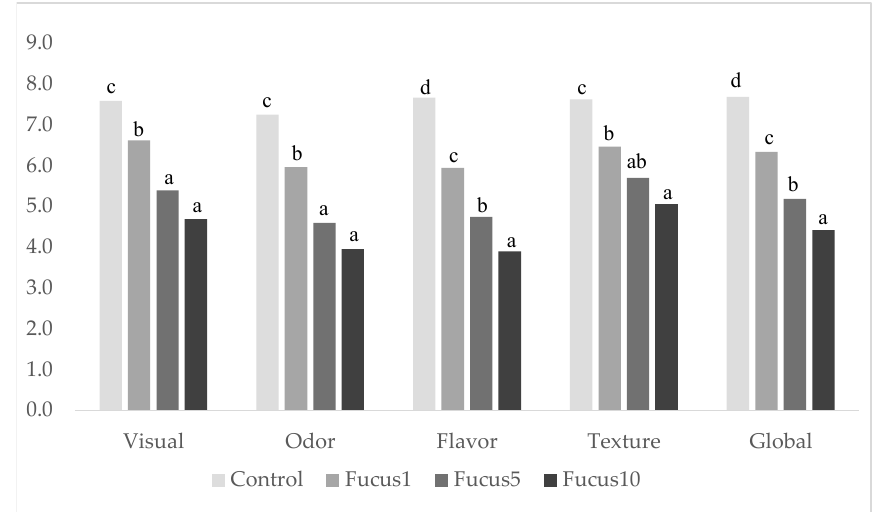
Figure 2. Sensory scores of semolina pasta (CTRL) and pasta enriched with F. vesiculosus (F1, F5, F10) by an untrained panel. Attribute intensity was rated on a 9-point scale ranging from extremely dislike (1) to extremely like (9 points). Different superscript letters correspond to significant differences within each column.